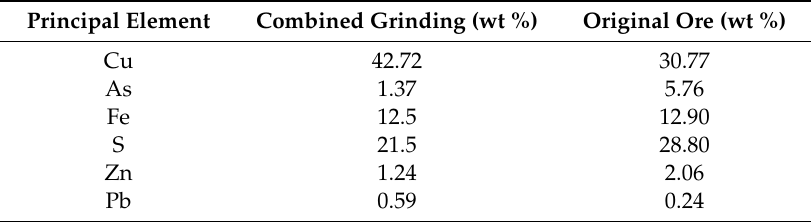
Table 3. Chemical composition of copper ore concentrate used in this study, analyzed by